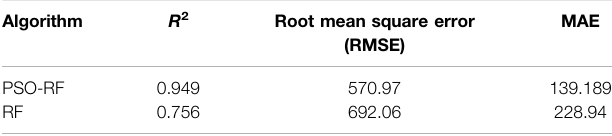
TABLE 1 | Prediction results of particle swarm optimization (PSO)-random forest (RF) and RF.